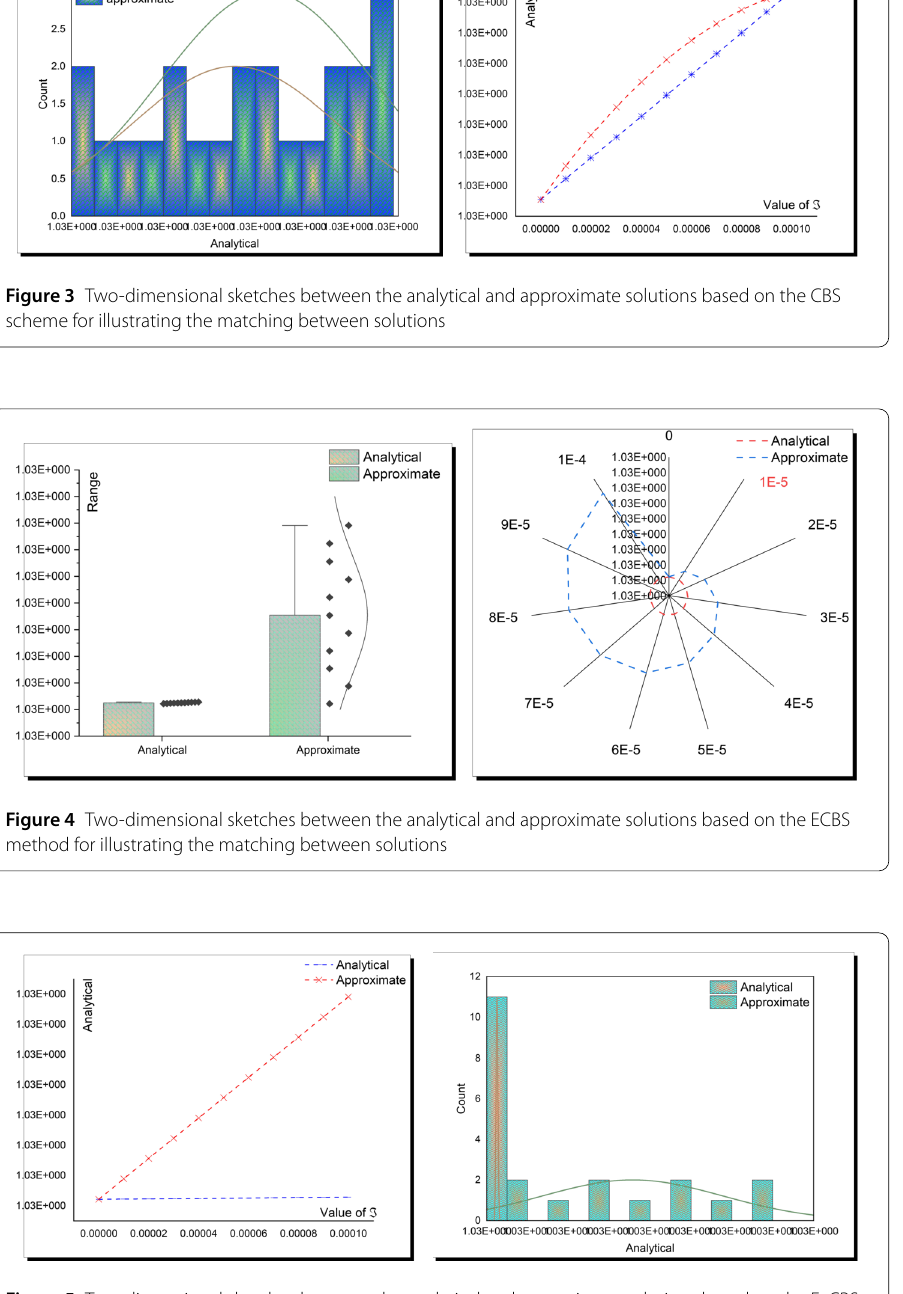
techniques. Additionally, all these tables and figures demonstrate the superiority of the ESE method over the other used analytical schemes in [1]. Moreover, they show the CBS method’s power as it gives the most accurate solutions over the above-used numerical schemes